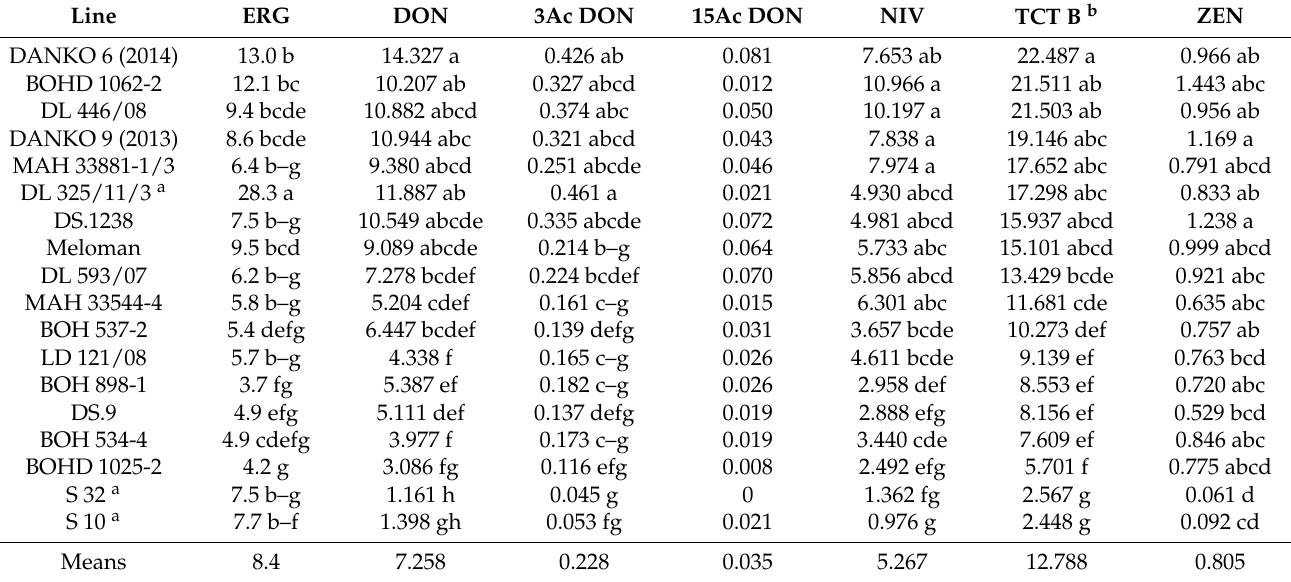
Table 3. Concentration of ergosterol (mg/kg), type B trichothecenes (DON, 3AcDON, 15AcDON, NIV, and TCT B) (mg/kg) and zearalenone (mg/kg) in grain of 15 winter triticale and three winter wheat lines. Line ERG